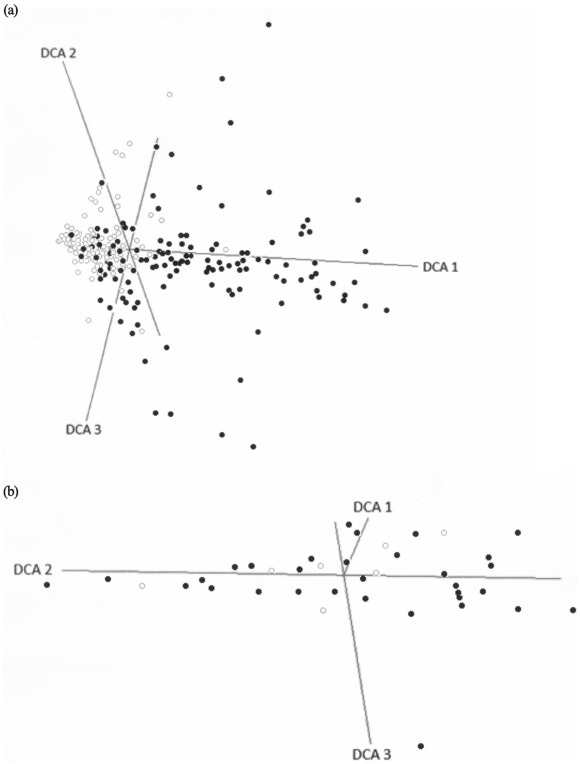
Three space ordination plots from detrended correspondence analyses for plant and arthropod richness sampled at three alpine sites on cushions and paired open non-vegetated microsites.Black points represent cushion microsites while open grey points show open microsites.